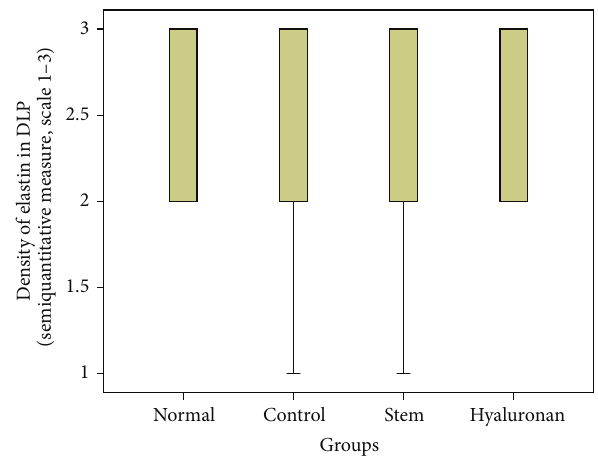
Figure 19: Density of elastin in the deep lamina propria (DLP). Normal = normal/control group, control = scarred/control group, stem = stem cell group, and hyaluronan = hyaluronan group.